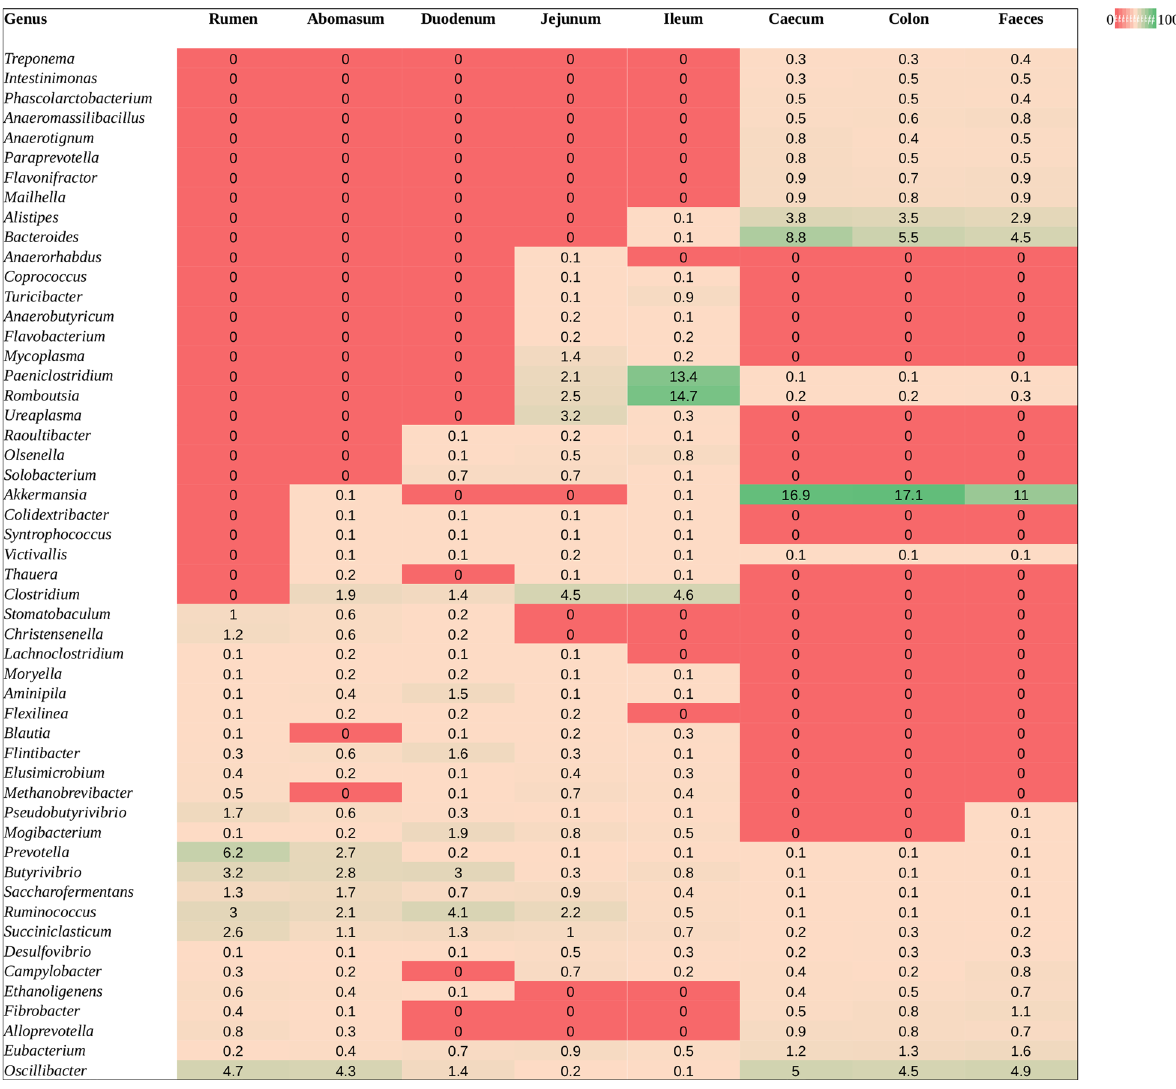
Fig. 4 Heatmap showing significant difference in bacterial abundance among gastro-intestinal tract (GIT) segments at genus level, based on ANCOM analysis. Each value represents the median relative abundance in